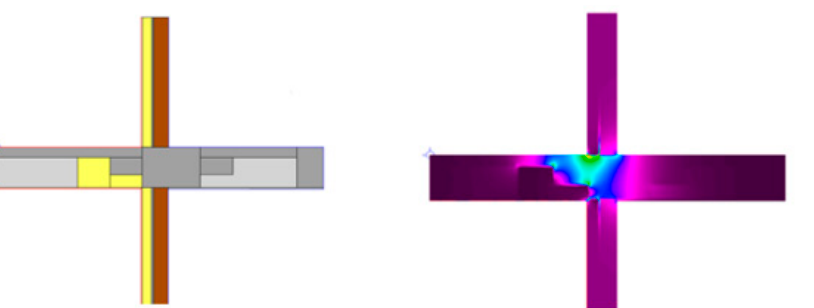
Figure 6. Improvement of thermal bridges in façade 1. ( Left ): construction detail. ( Right ): calculated heat flux. Table 2. Proposed renovation measures for thermal bridges.